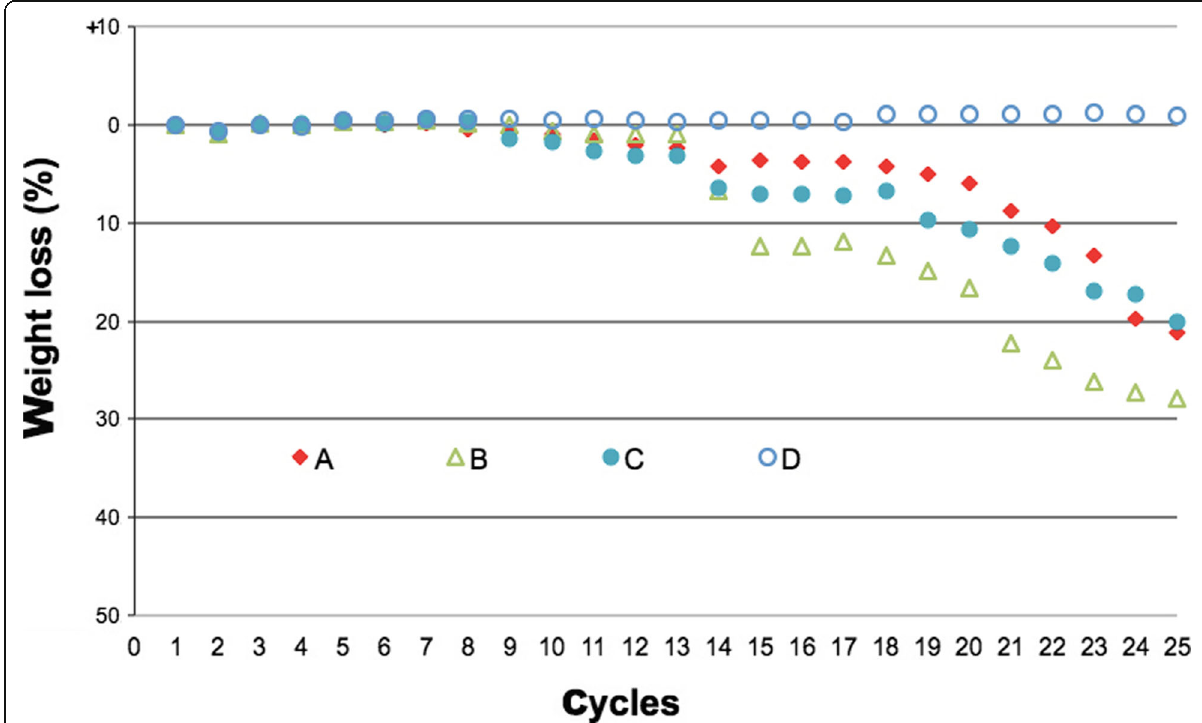
Fig. 6 Average weight loss (%) of the tested specimens (A, B, C, and D, see sample description in Table 1) (please note that there is an overlap between the symbols up to 10